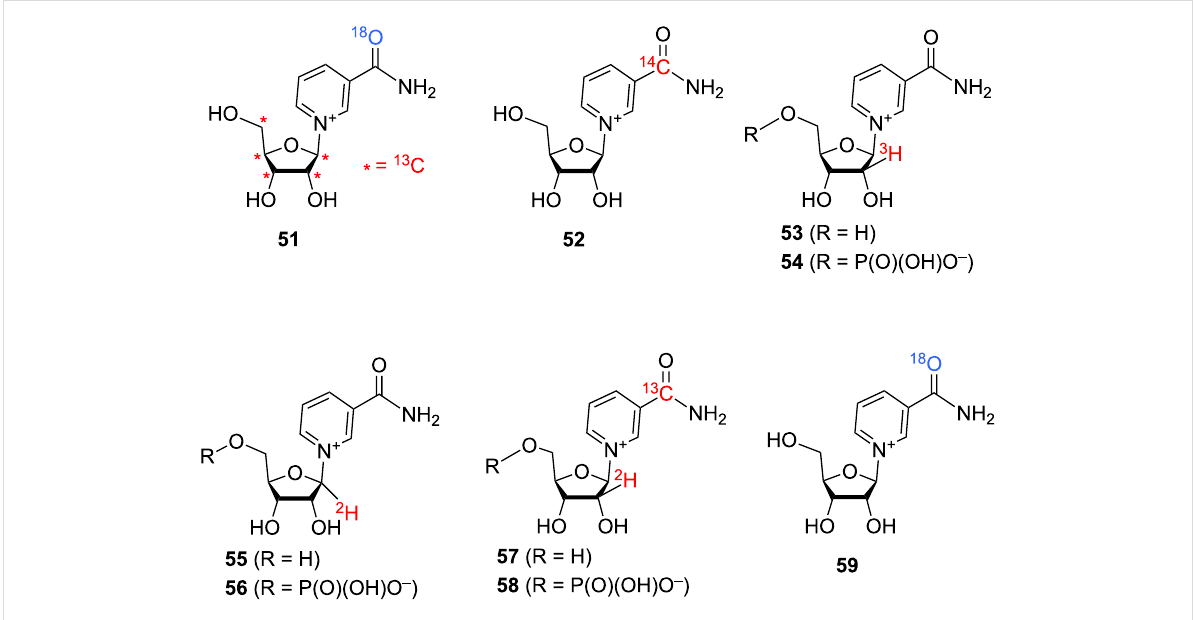
Figure 12: Chemical structures of known isotopically labelled NR + analogues and derivatives.